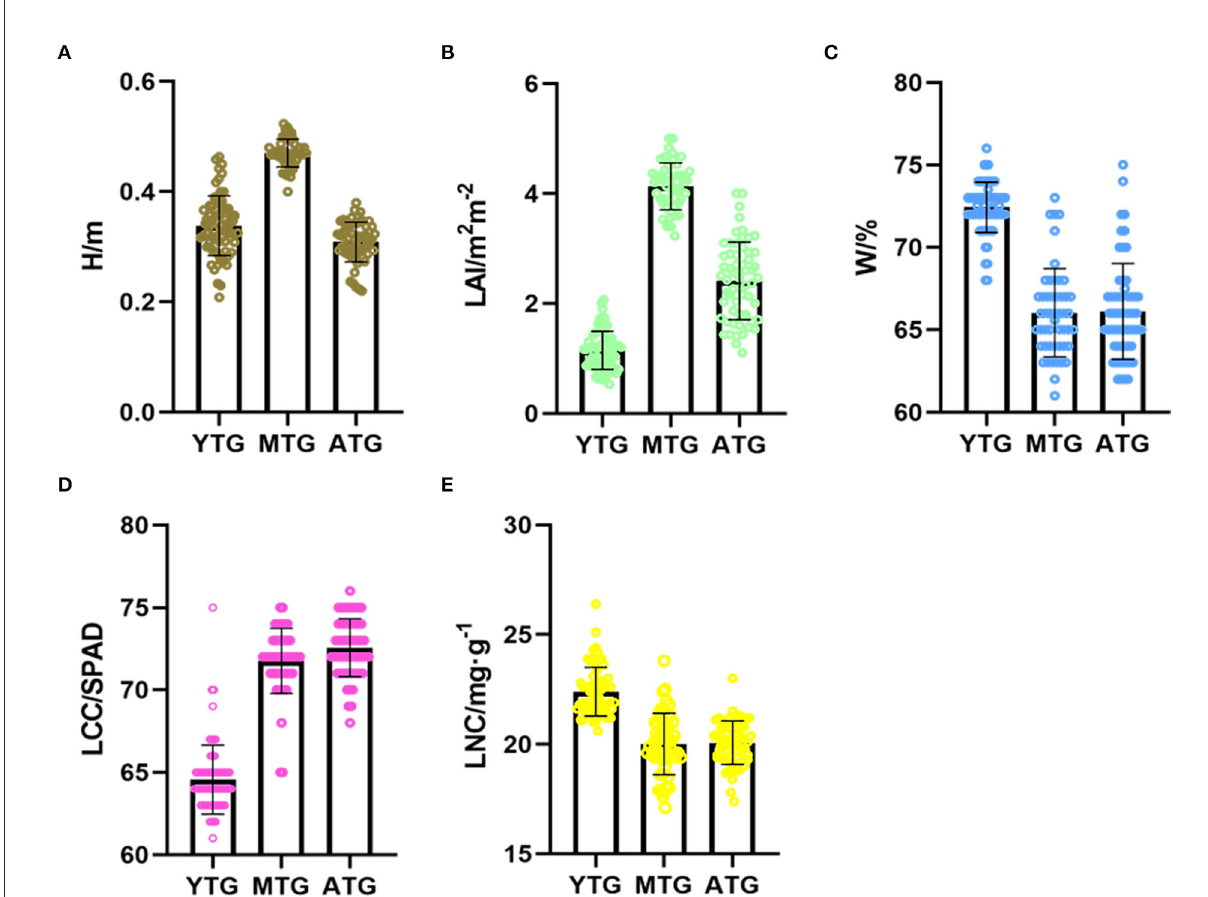
FIGURE5 Phenotypes of tea crowns at different growth stages. (A) H; (B) LAI; (C) W; (D) LCC; (E)